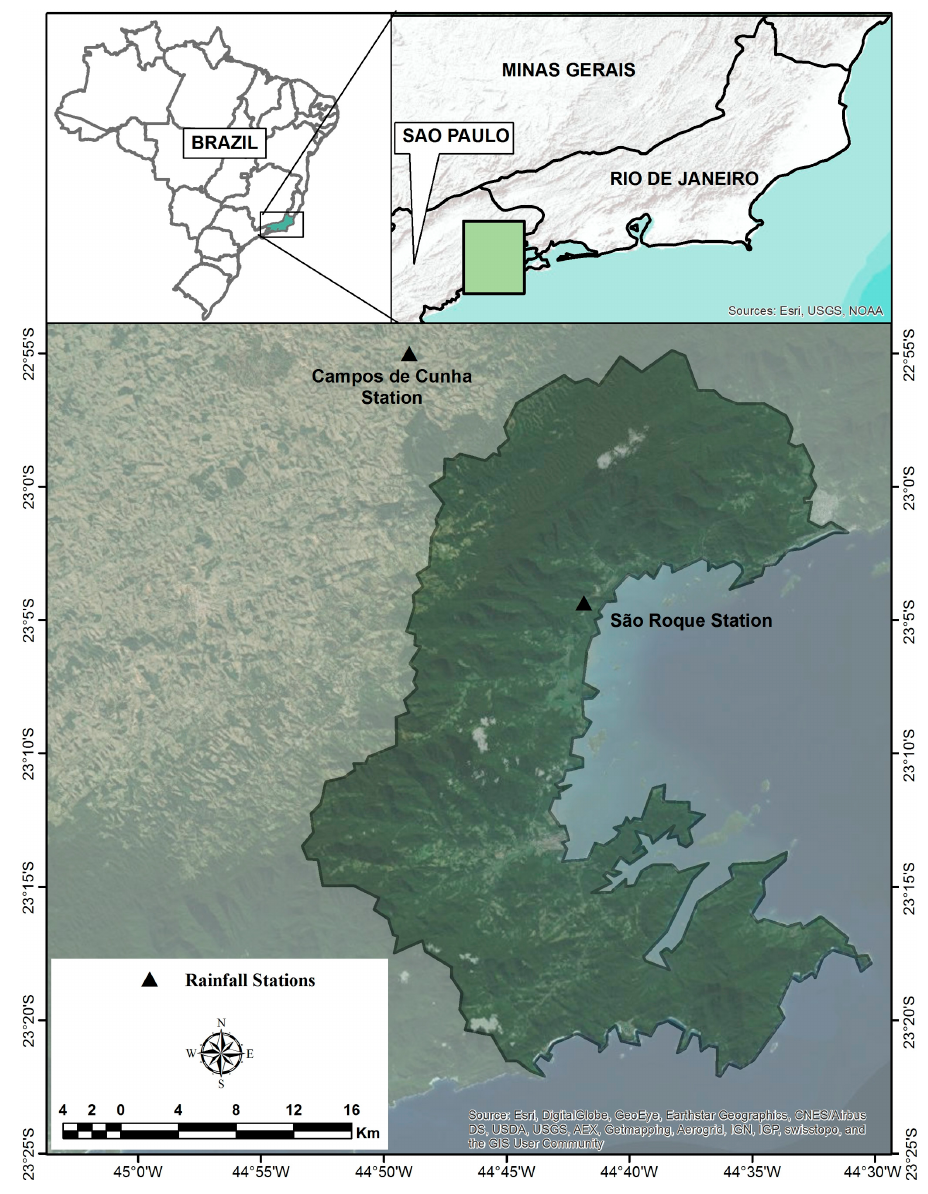
Figure 1. Study area showing location of rain gauges at Campos de Cunha and São Roque. Table 1. Annual rainfall (mm) for São Roque and Campos de Cunha rainfall stations.